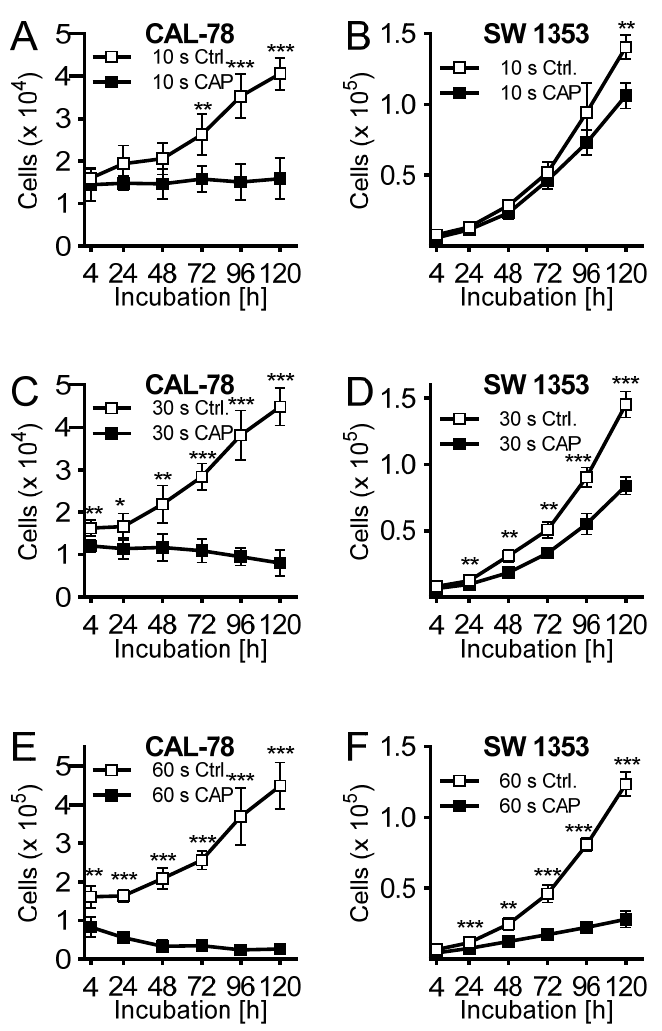
Figure 2. The human chondrosarcoma cell lines CAL-78 ( A , C , E ) and SW 1353 ( B , D , F ) were treated 24 h after seeding with cold atmospheric plasma (CAP). For CAP treatment, cell culture media was exposed to 10 ( A + B ), 30 ( C + D ), or 60 s ( E + F ) CAP or carrier gas argon with kINPen med (neoplas tools, Greifswald, Germany). Living cells were counted with CASY Cell Counter and Analyzer (OLS, Bremen, Germany) 4, 24, 48, 72, 96, and 120 h after exposure. Data were given as Mean ± SD; significant differences were indicated as follows: * p ≤ 0.05, ** p ≤ 0.01, *** p ≤ 0.001.